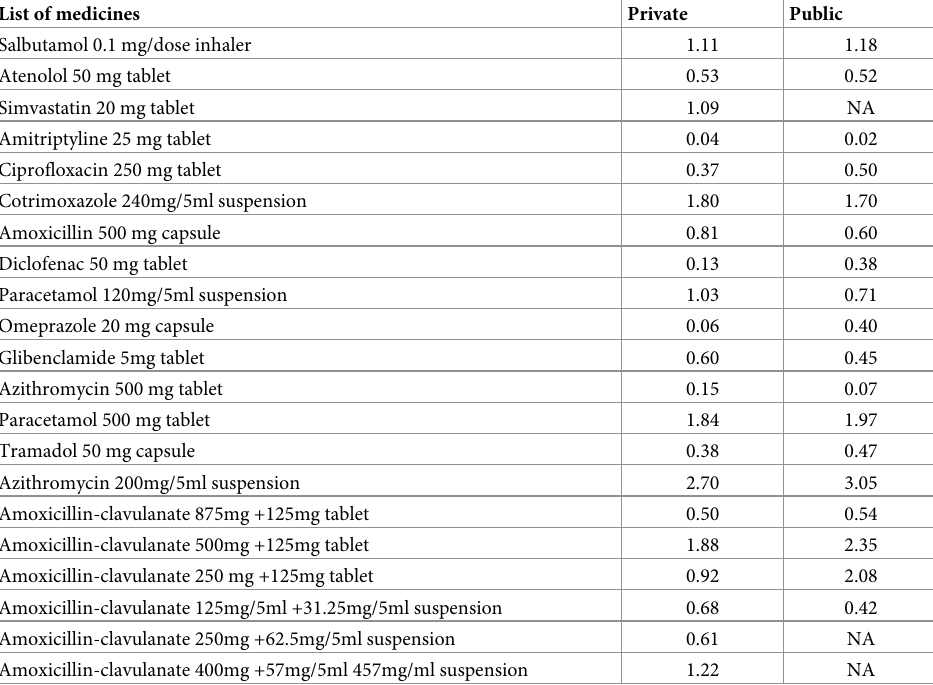
Table 4. MPR of medicines in health facilities of Dessie town, 2021. List of medicines